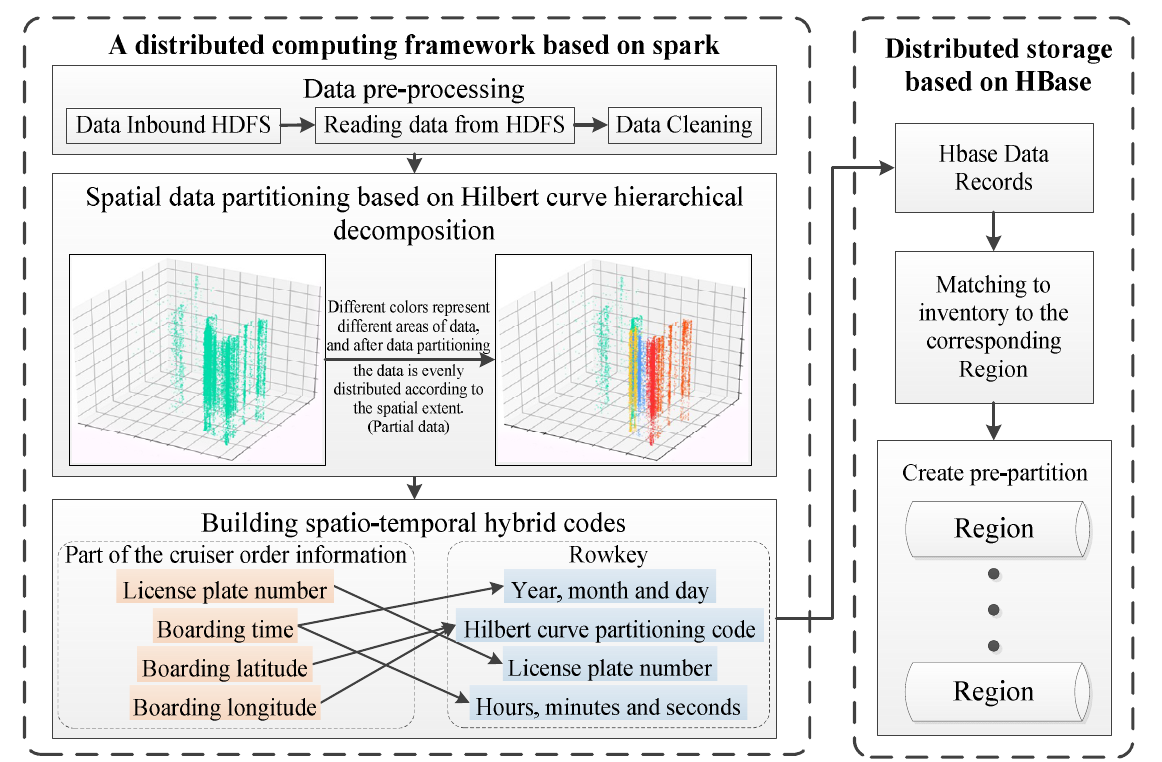
Figure 2. Data storage model incorporating data partitioning and spatio-temporal multidimensional hierarchical organization.